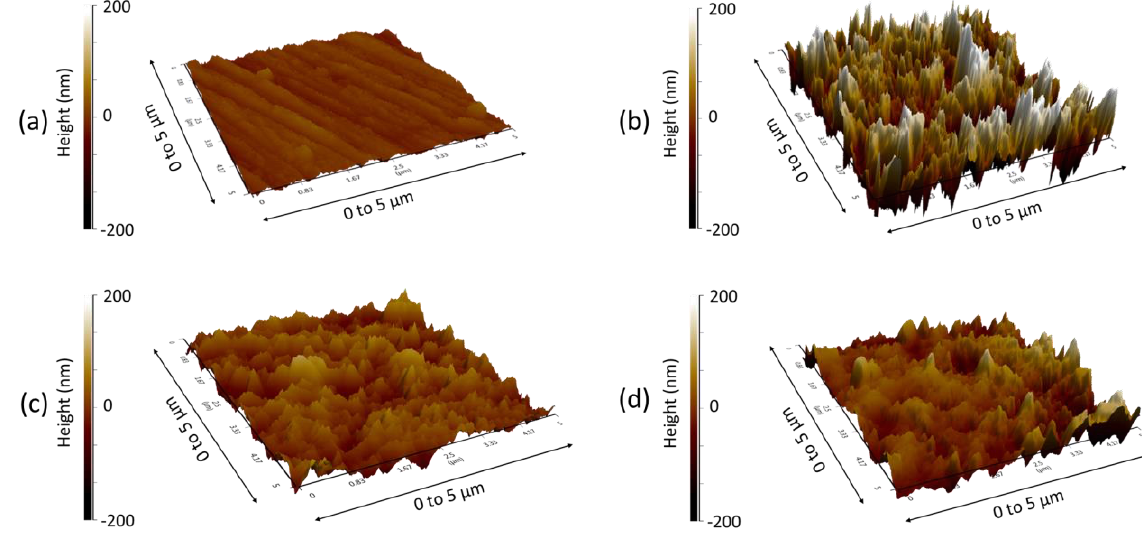
Figure 10. AFM images of EN3B mild steel ( a ) Polished ( b ) Immersed in 3.5% NaCl, pH = 1.5 without inhibitor ( c ) In the presence of 10 mM Py8 and ( d ) 10 mM Py12.